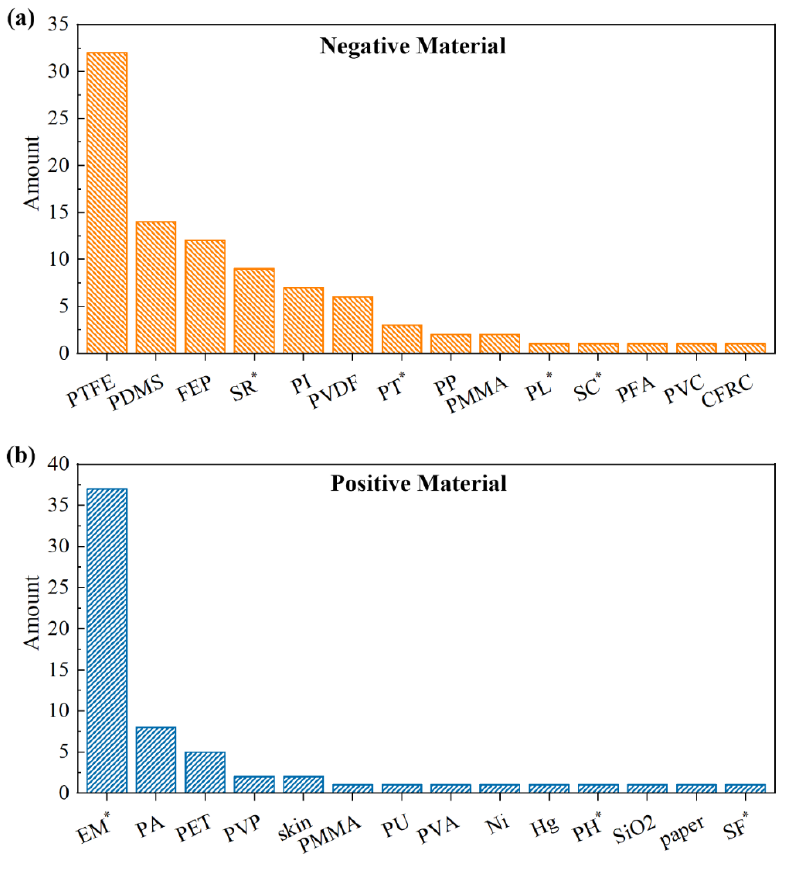
Figure 8. The statistics histogram of ( a ) negative materials of tribo-pair, and ( b ) positive materials of tribo-pair. * represents the abbreviation: SR (silicone rubber); PT (P(VDF-TrFE)); PL (Parylene); SC (silicone); EM (electrode material); PH (PDMS/PVDF-HFP); SF (silk-fibroin).